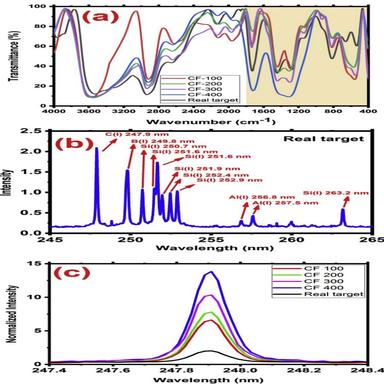
(a) FT-IR spectra of carbon fiber reinforced polymers composite materials at different densities and the real target sample, (b) elemental analysis of real target by LIBS technique, and (c) LIBS normalized spectra of the different density of carbon-fiber and the real target.